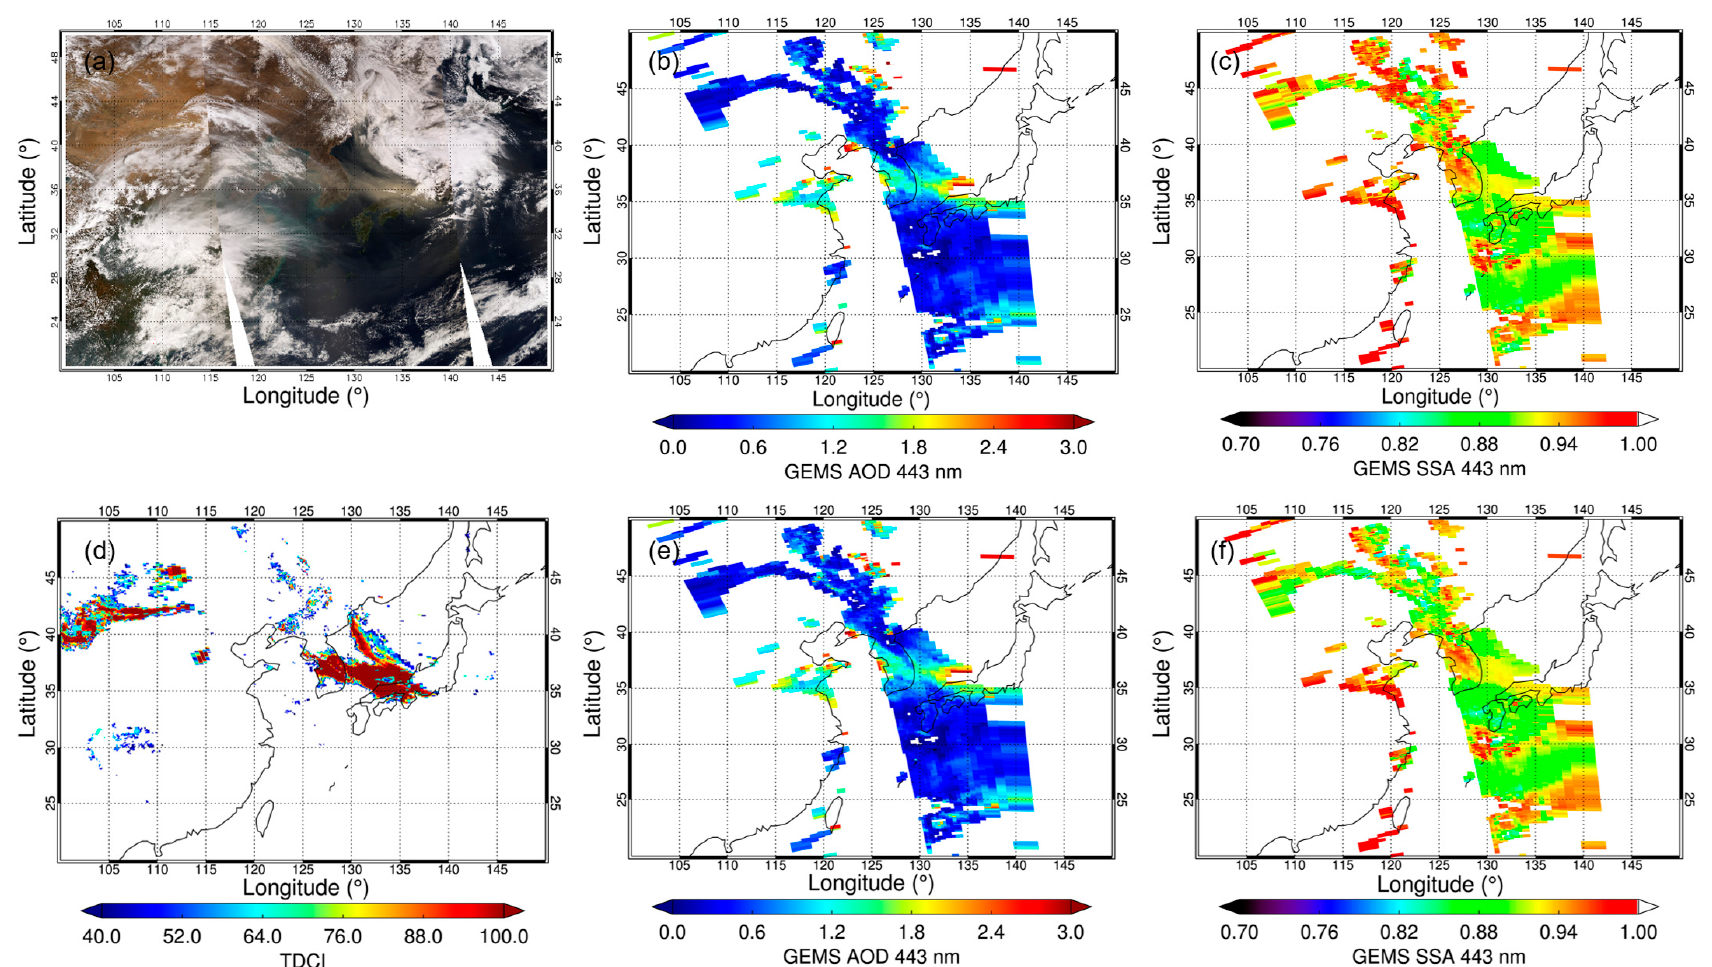
Figure 6. ( a ) MODIS RGB for 8 April 2006; ( b ) GEMS AOD before applying the TDCI-corrected aerosol type; ( c ) GEMS single-scattering albedo (SSA) before applying the TDCI-corrected aerosol type; ( d ) TDCI calculated with MODIS; ( e ) GEMS AOD after applying the TDCI-corrected aerosol type; ( f ) GEMS SSA after applying the TDCI-corrected aerosol